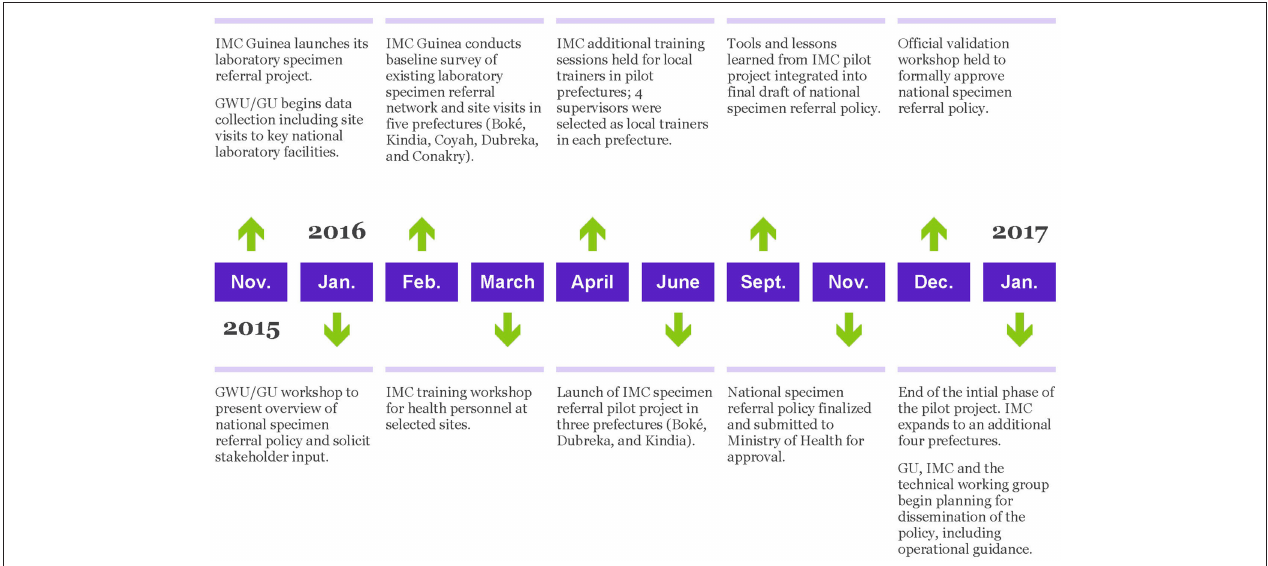
FIGURE 1 | Building the national specimen referral system in Guinea - key project